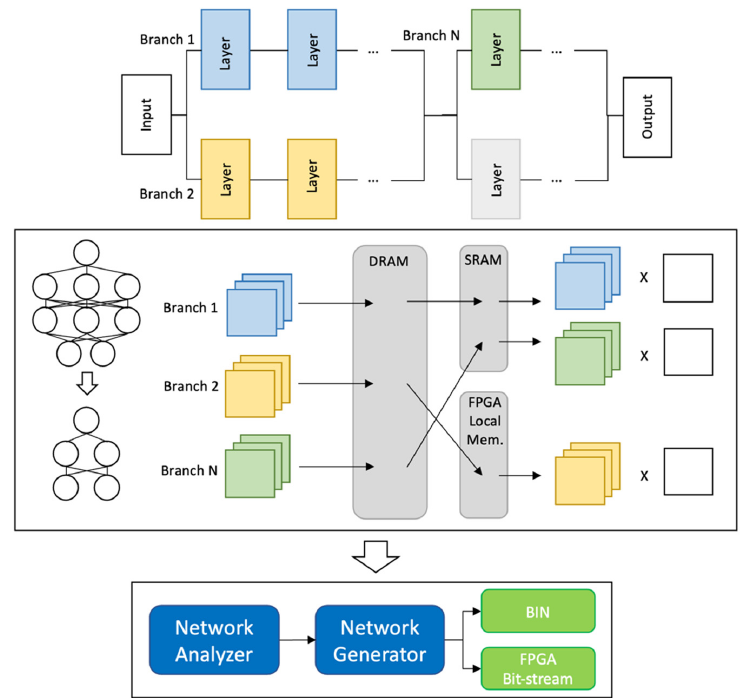
Figure 3. Proposed system overview.